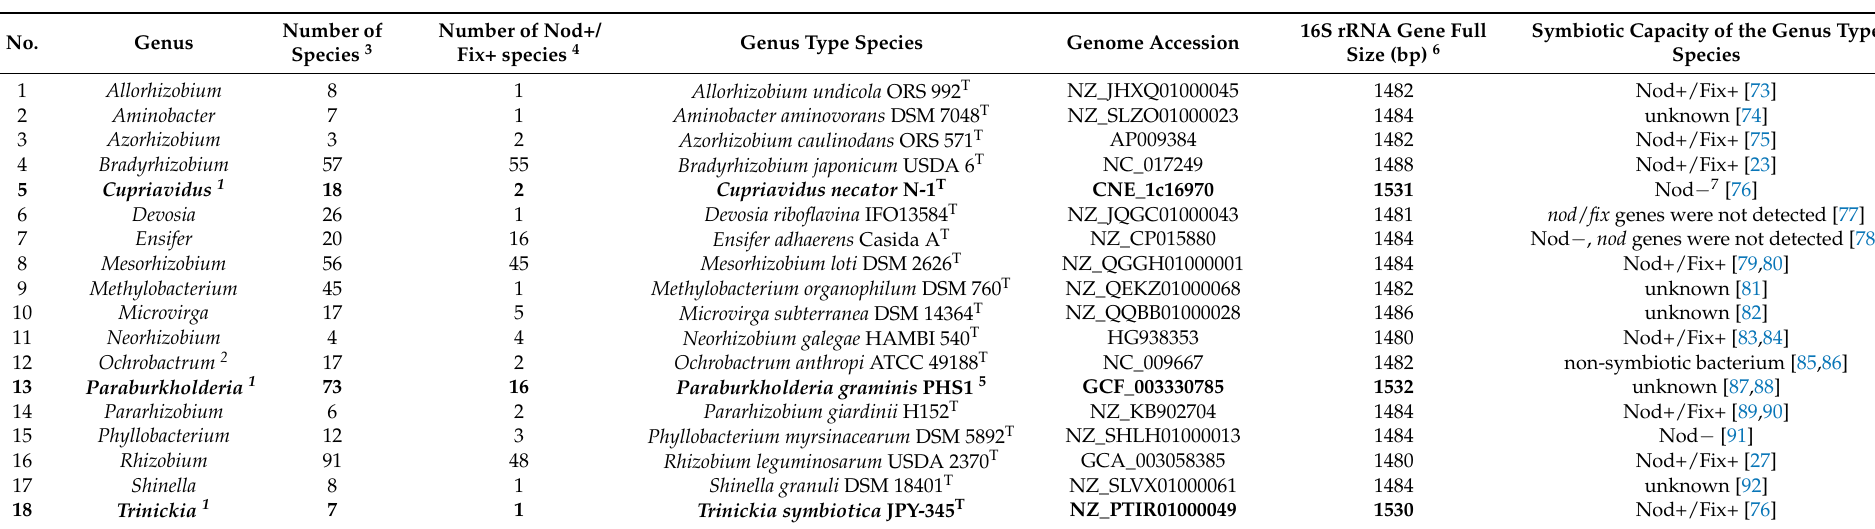
Table 2. A list of the 18 alpha-and beta-proteobacterial genera harboring rhizobia, their type species used in this study and their corresponding relevant characteristics.